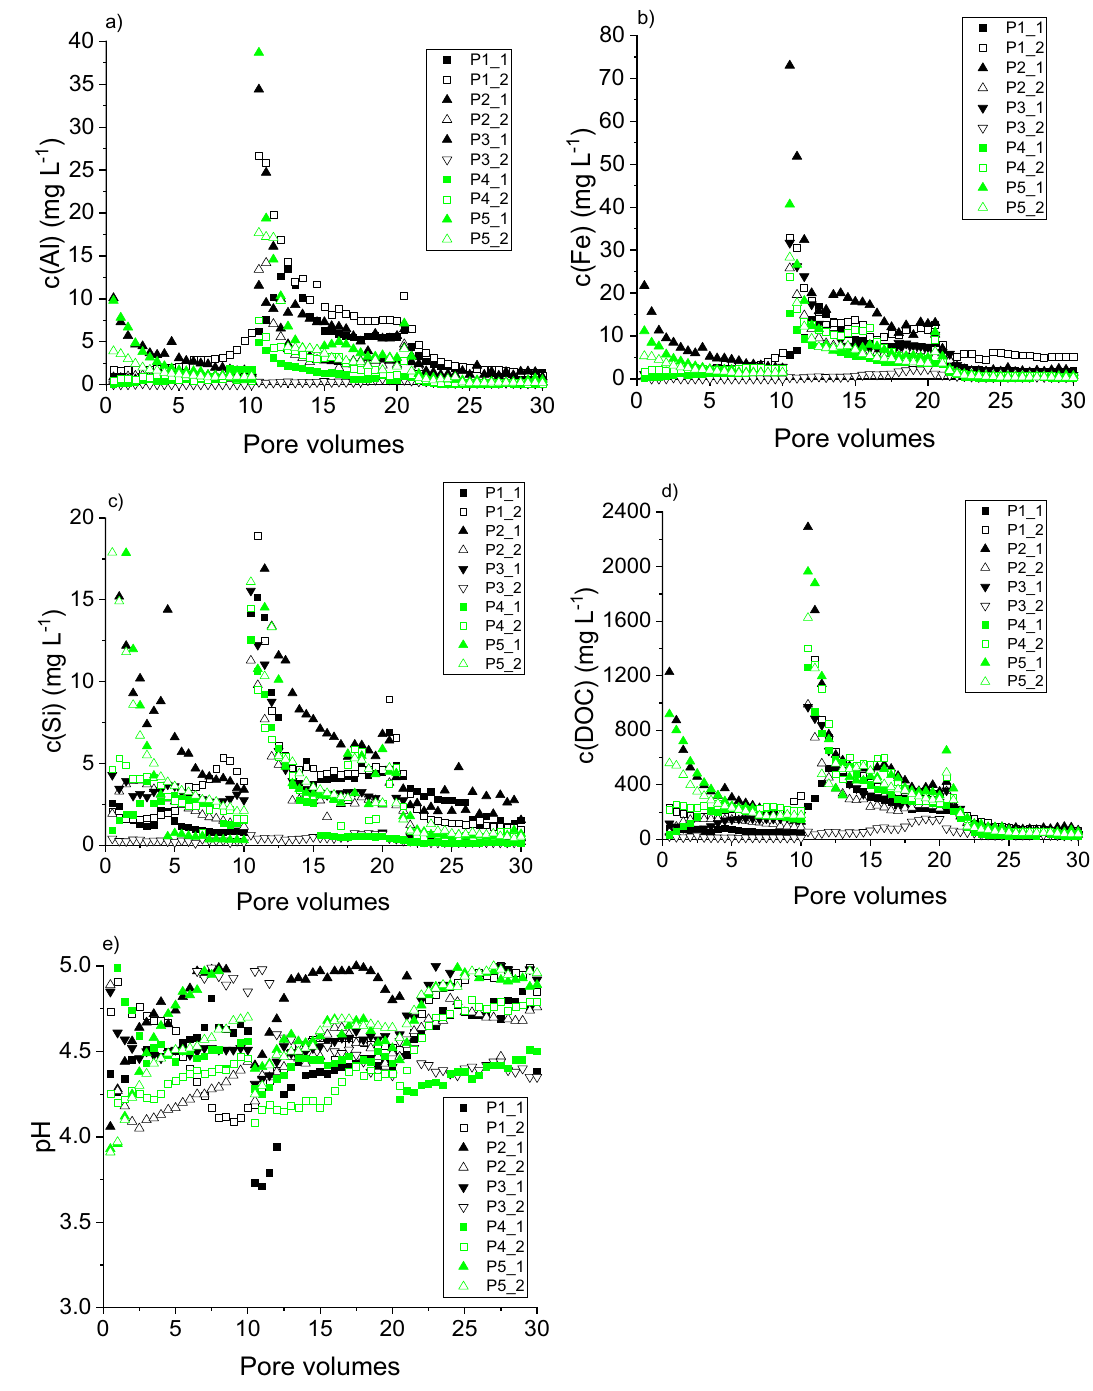
Figure 2. Elemental concentrations ( a–d ) and pH in eluates from irrigation experiments with soils with increasing degrees of podzolisation (P1 to P5). ‘_1’ and ‘_2’ denote duplicate experiments. ( a ) Aluminium, ( b ) Iron, ( c ) Silicon, ( d ) Dissolved organic carbon, ( e )